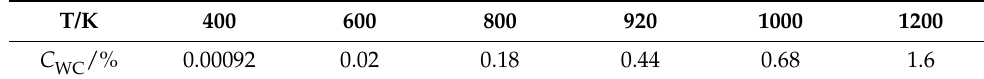
Table 2. Solubility of WC in Ti at different temperatures.